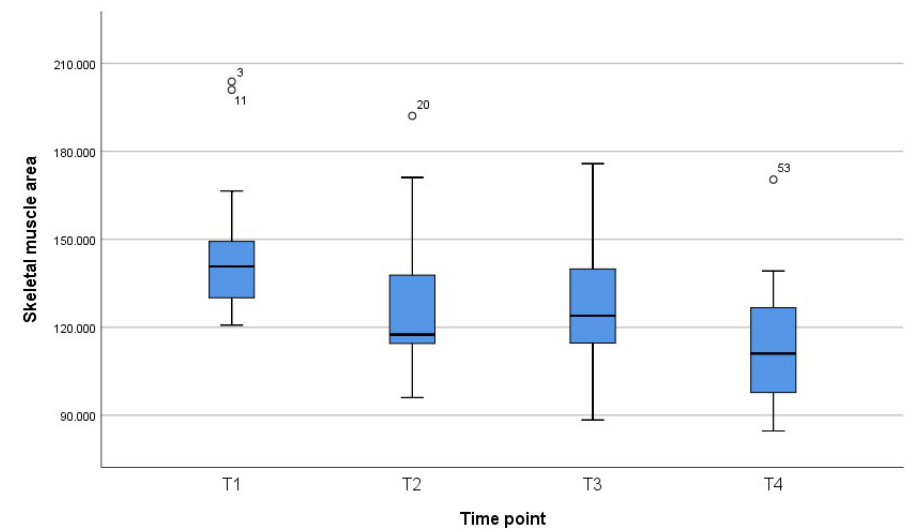
Figure 3. Box plot for SMA for different time points.